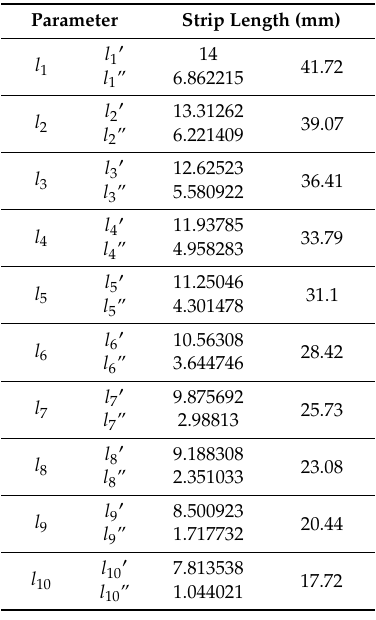
Table 1. Physical lengths of the strip resonators.